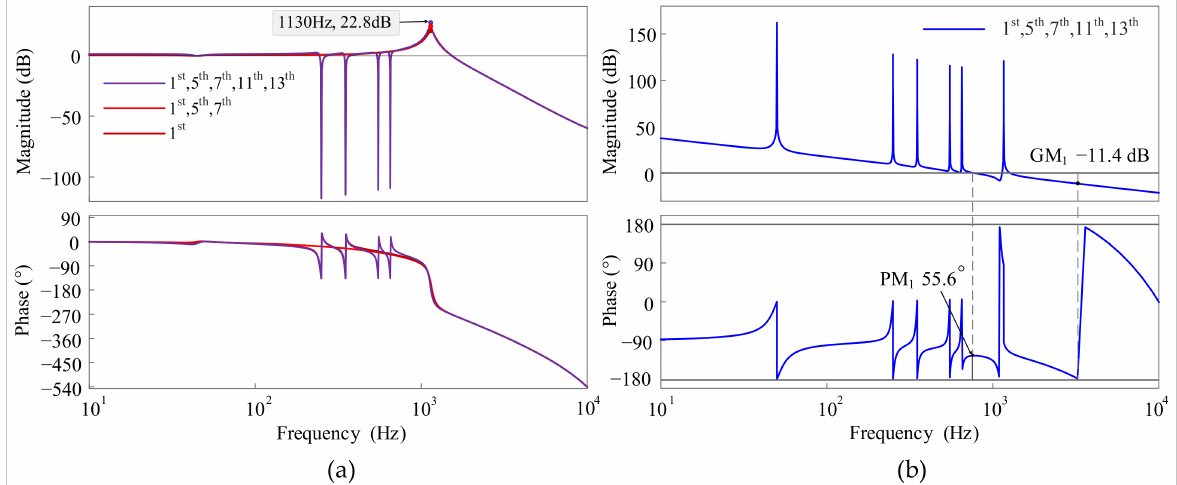
Figure 4. Bode plots of the corresponding transfer functions: ( a ) Bode plots of the closed-loop transfer function G cl (cid:48) ( s ) when different numbers of resonance controllers are used; ( b ) Bode plot of the open-loop transfer function G ol ( s ) when L g = 0.